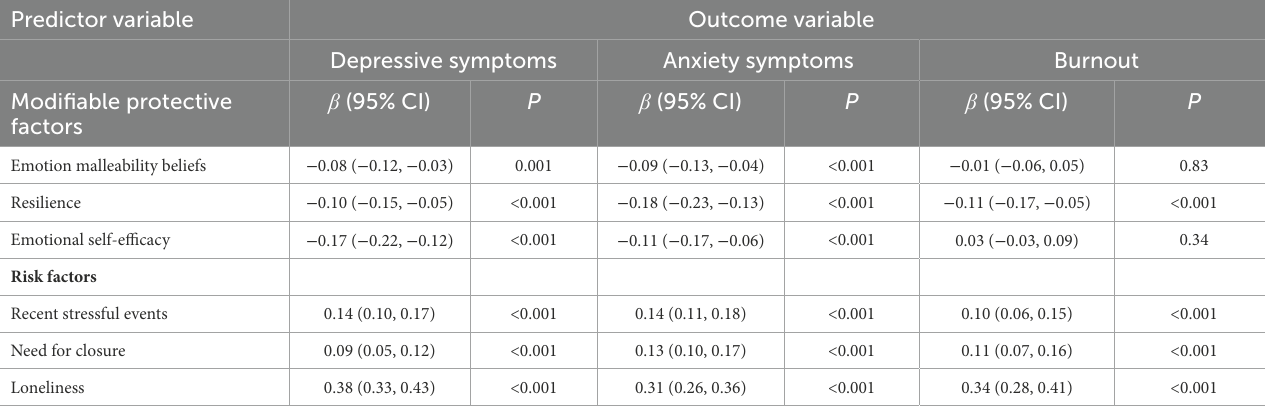
Standardized beta coefficients ( β ) are presented for all models. Models included the following covariates: binary gender, sex, race, and ethnicity, whether in a relationship, better or worse off financially due to the pandemic (reference group: no impact of pandemic), less than or more than four-year college degree attainment (reference group: four-year college degree), social desirability, and dispositional optimism. Analyses only included participants with binary gender identity due to too small of a sample size for non-binary gender, which was underpowered to test for any statistically significant differences for this group. N =